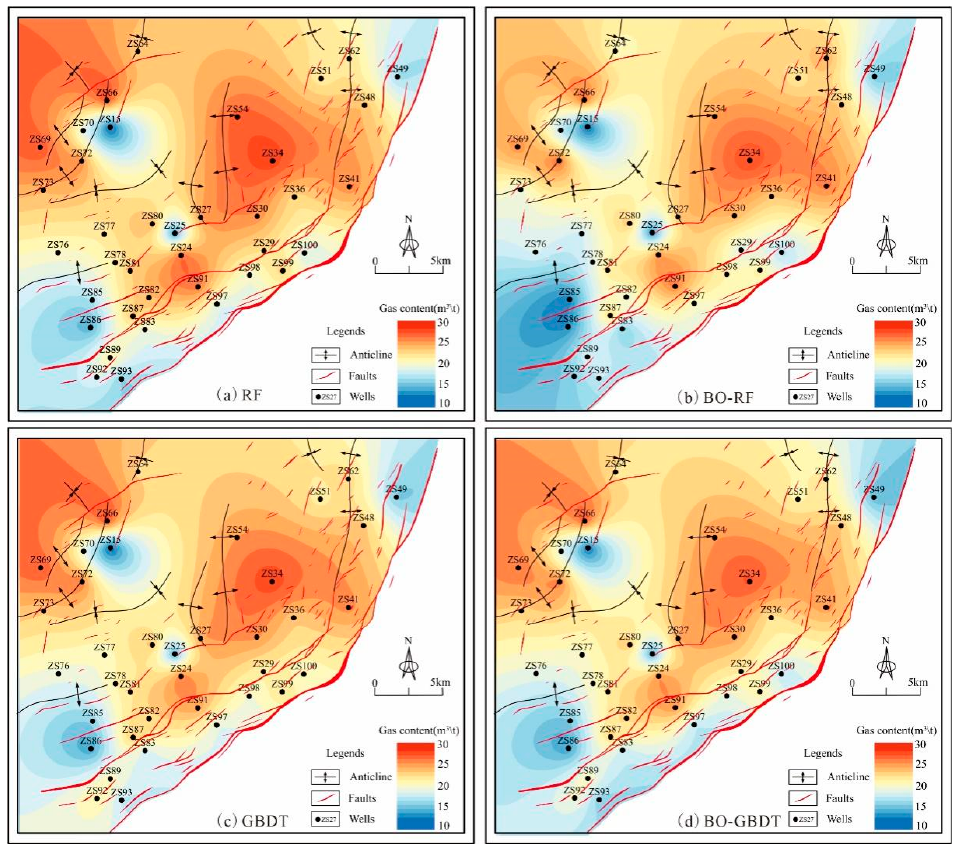
Figure 13. Gas content distribution predicted by different models ( a RF model; b BO-RF model; c GBDT model; d BO-GBDT model).